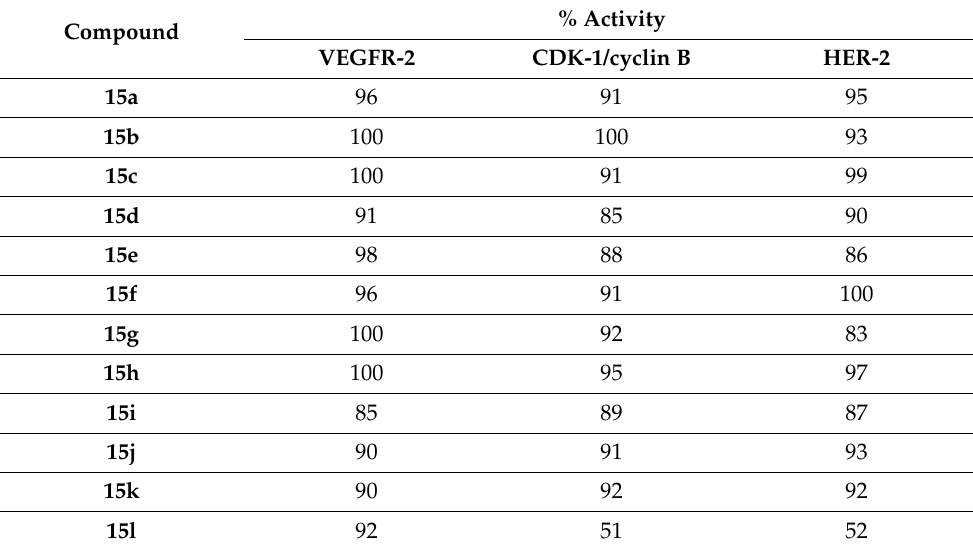
Table 2. Kinase activity (%) of the tested compounds ( 15a–l ) over VEGFR-2, CDK-1/cyclin B and